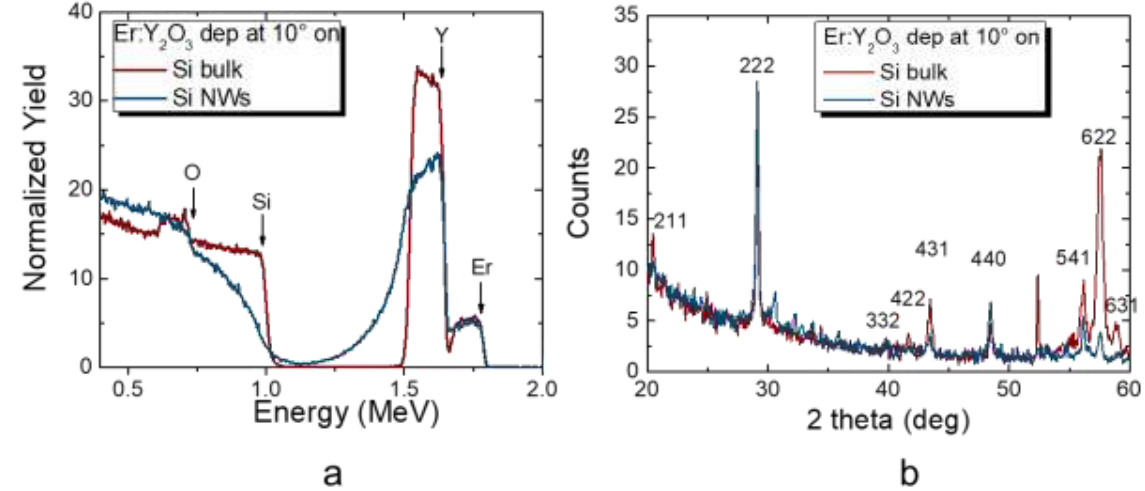
Figure 3. ( a ) Rutherford backscattering spectrometry of the decorated Si bulk (red) and Si NWs (blue) obtained at 10°. ( b ) X-ray diffraction analysis of the Er:Y 2 O 3 deposited on Si bulk and Si NWs at 10°.